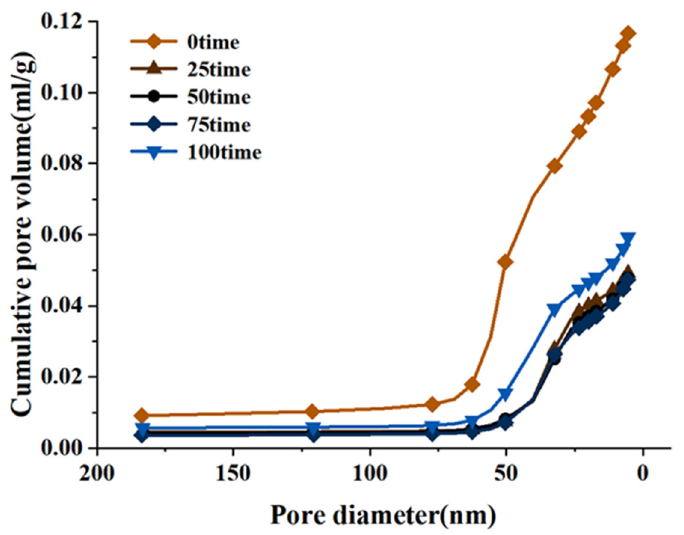
Figure 13. Relationship between pore size distribution and cumulative mercury content of cement paste under different freeze-thaw cycles.